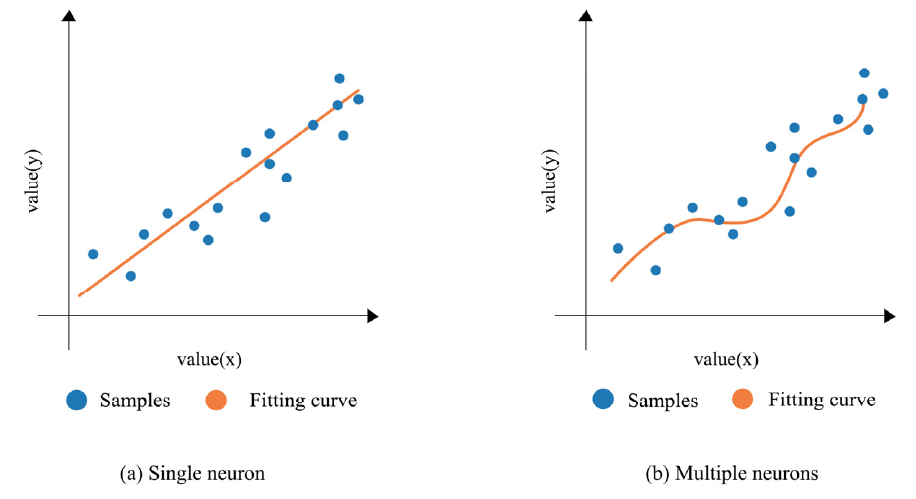
Figure 4. Neural network fitting curve comparison.